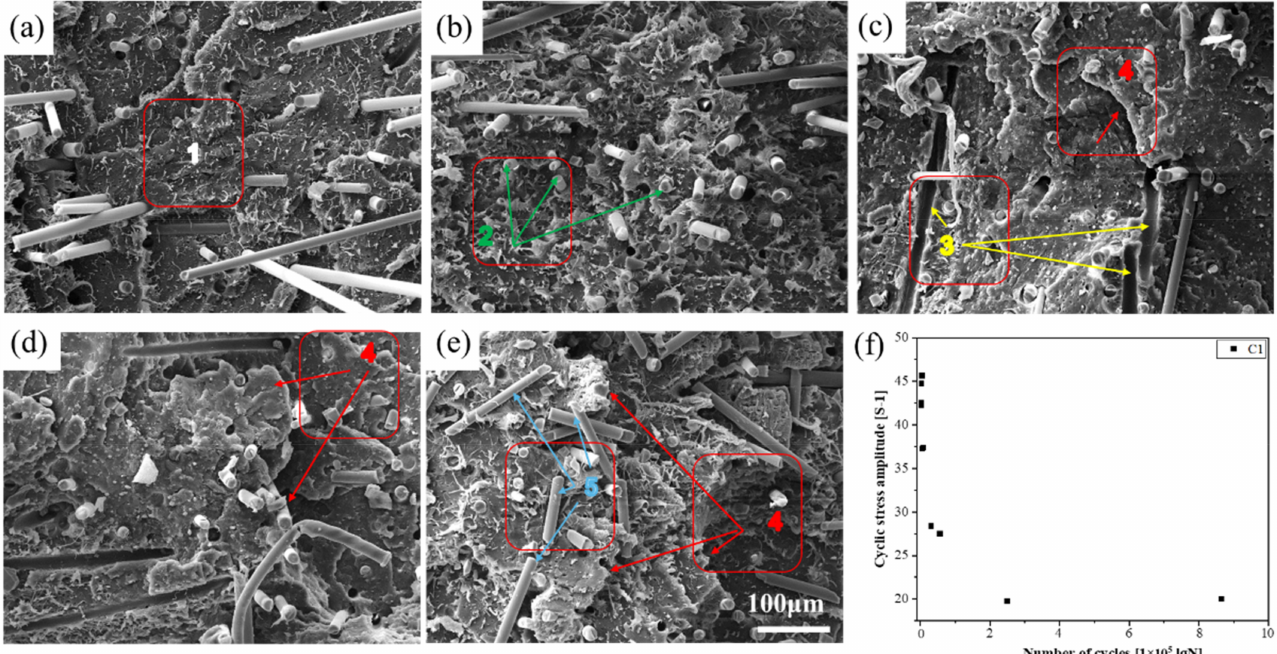
Figure 9. The fracture morphology and fatigue point of C1 at the following stress levels: ( a ) 30%, ( b ) 40%, ( c ) 55%, ( d ) 65%, and ( e ) 75% (area 1, craze; area 2, fiber fracture; area 3, fiber pull-out; area 4, layered peeling; and area 5, fractured BF); and ( f ) fatigue point of